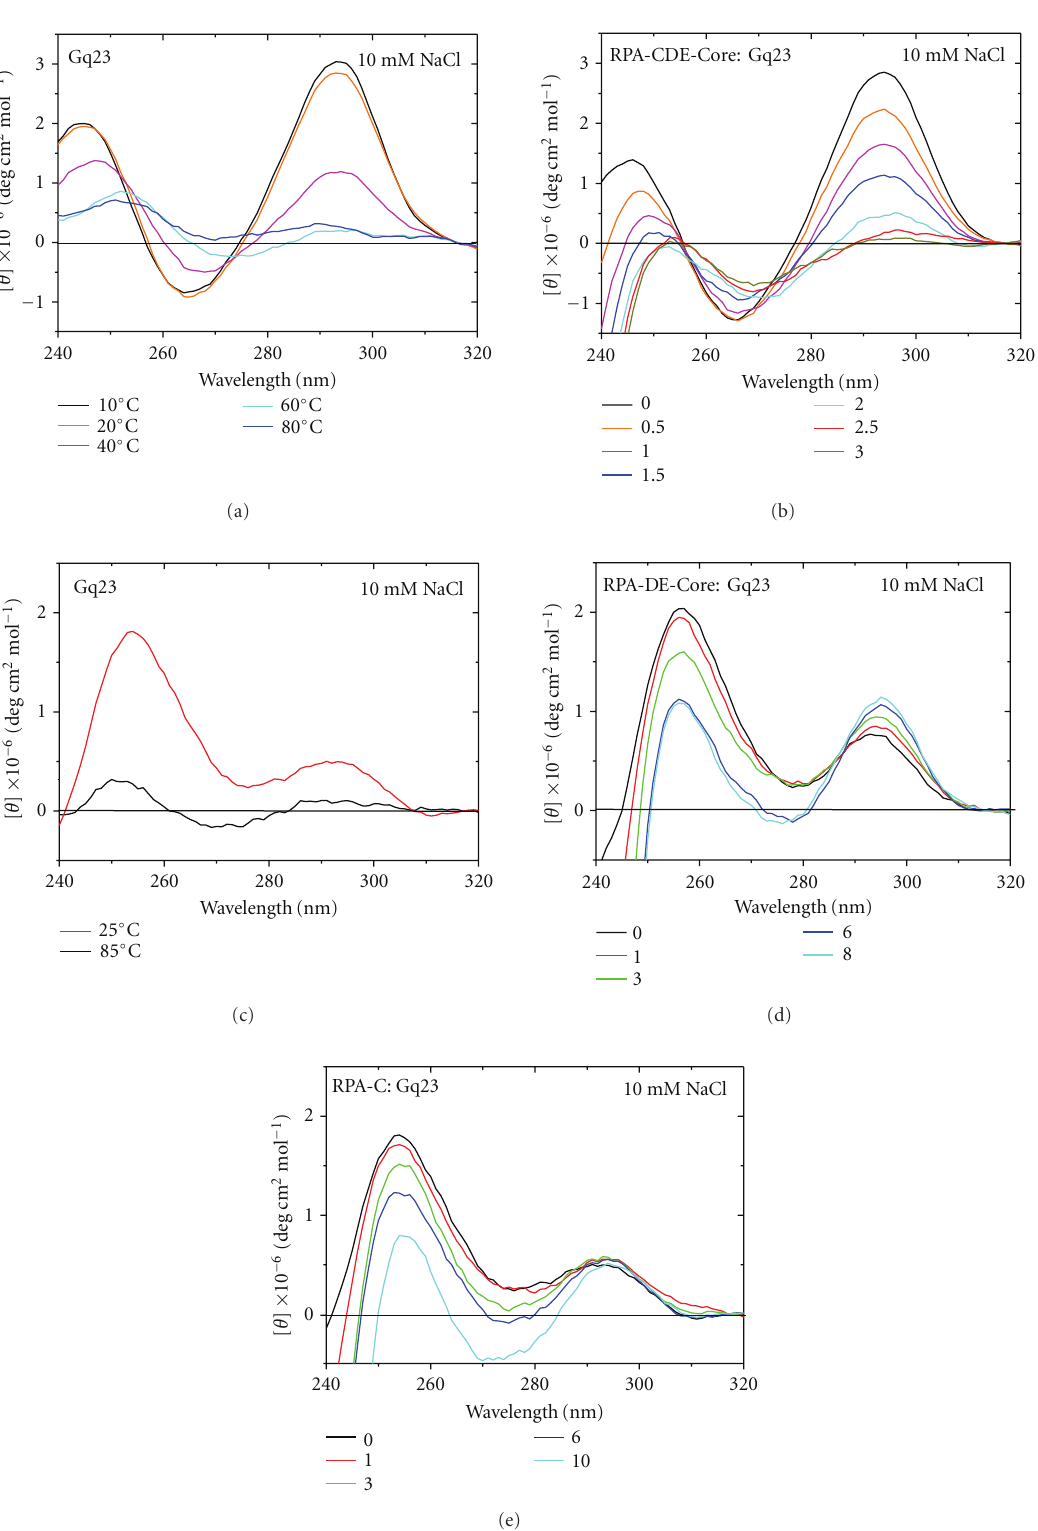
Figure 6: CD experiments for Gq23 oligonucleotide melting and protein titrations with RPA-CDE, RPA-DE, and RPA-C. (a) Melting of Gq23, (b) Titration of Gq23 with RPA-CDE at varying protein:ssDNA ratios. Peak at ∼ 292 nm indicates the presence of an antiparallel G-quadruplex. Parts (a) and (b) were collected in Bu ff er A with 100 mM NaCl. (c) Melting of Gq23 in 10mM NaCl, (d) Titration of Gq23 with RPA-DE, and (e) Titration of Gq23 with RPA-C. Parts (c–e) were collected in Bu ff er A with 10mM NaCl. Note, spectra contain both antiparallel and parallel (254 nm) G-quadruplex peaks